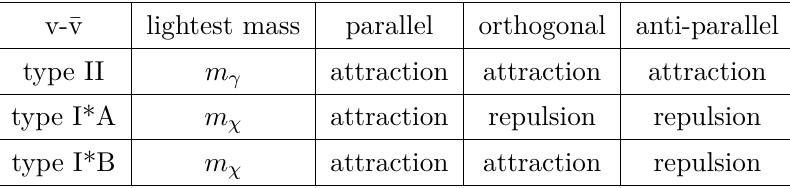
Table 3 . Static inter-vortex force between a non-Abelian vortex and